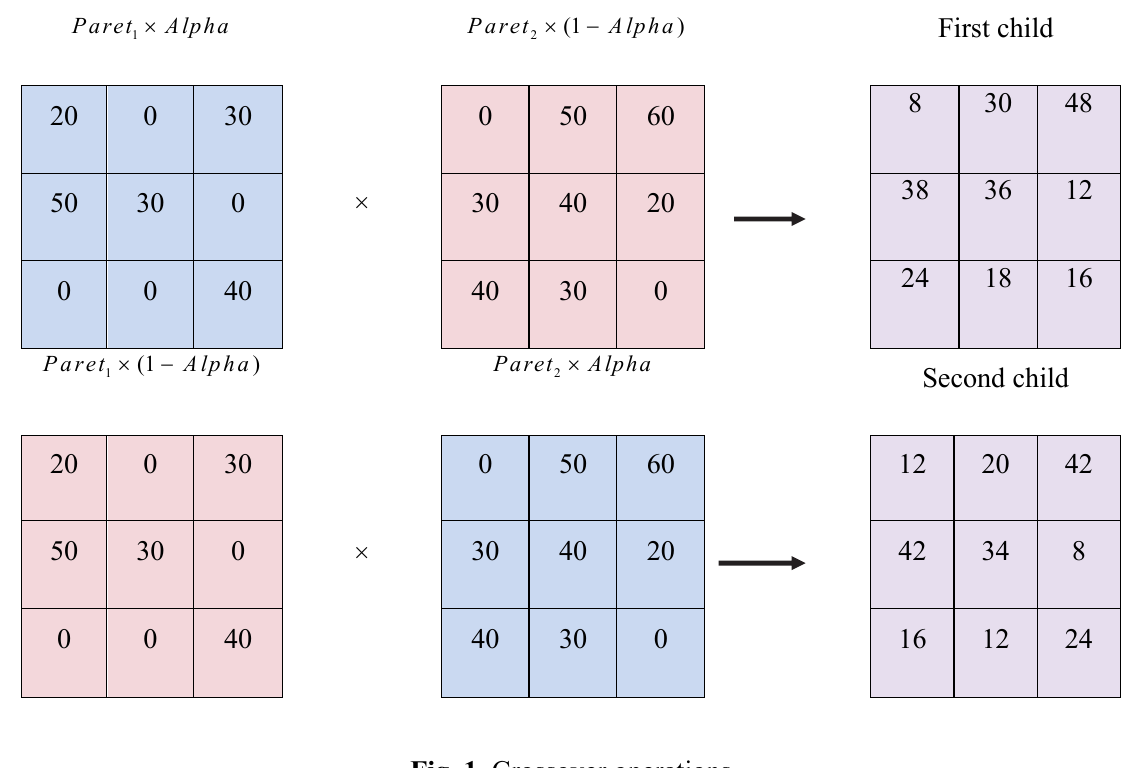
Fig. 1. Crossover operations